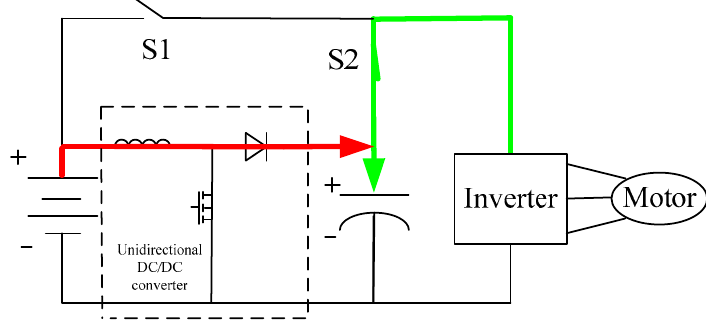
Figure 8. Mode 5—both the braking energy and battery charge the SC.